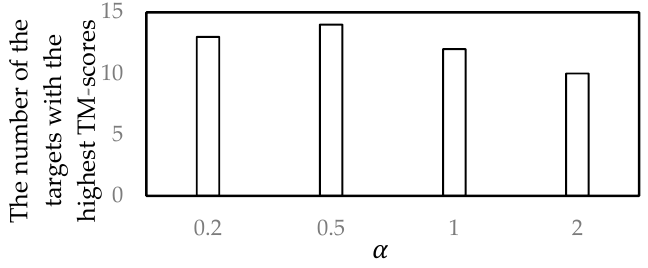
Figure 3: Parameter selection 239 Figure 3. Parameter